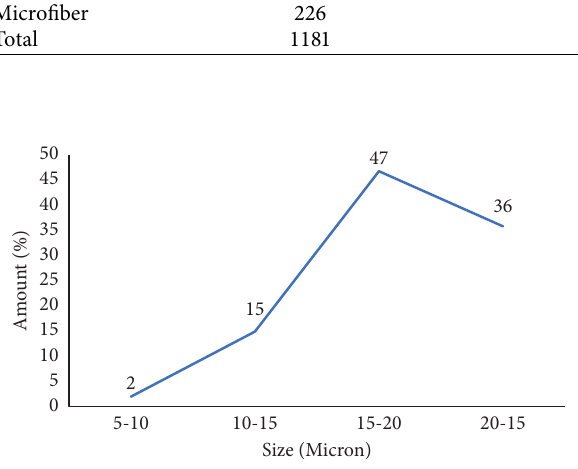
Figure 10: Size of the particles smaller than 25 μ m and their